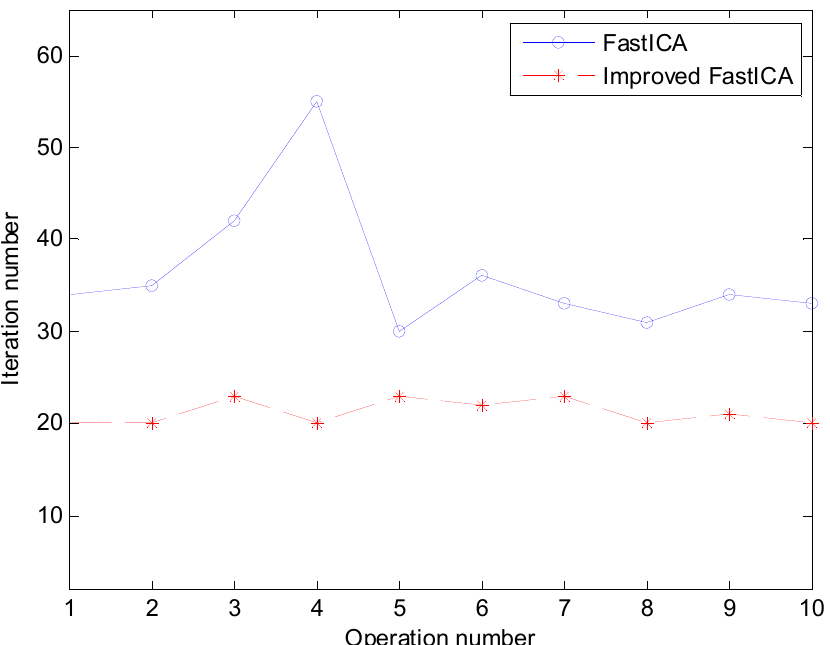
Figure 6. Iteration number under 10 runs using FastICA and improved FastICA.